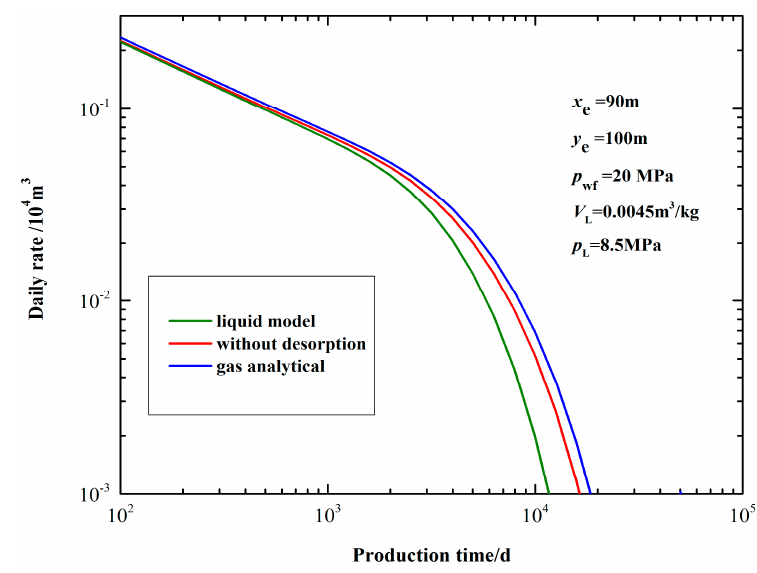
Figure 2. Change relationship of β ( t ) and β *( t ) over time.